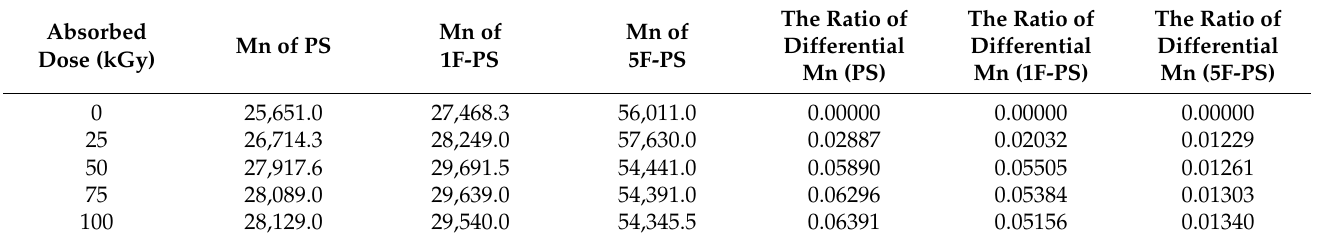
Figure 9. The polymers average molecular weight after irradiation (experiment results). Table 4. Maximum dissociation number of each bond in polystyrene @